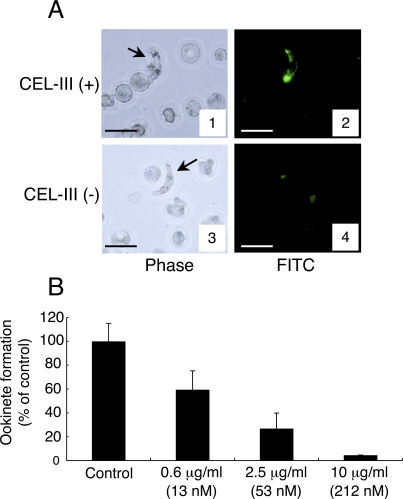
Binding of CEL-III to Ookinetes Inhibits Parasite Development In Vitro(A) Binding of CEL-III to ookinetes. CEL-III was added to cultured ookinetes purified from P. berghei–infected mouse blood. Bound CEL-III was detected with FITC-labeled anti-mouse IgG following mouse anti-CEL-III antibody by fluorescence microscopy (panels 1 and 2) (CEL-III (+)). As a negative control, ookinetes were incubated with FITC-labeled anti-mouse IgG following mouse anti-CEL-III antibody without CEL-III (panels 3 and 4) (CEL-III (−)). Panels 1 and 3, phase contrast; panels 2 and 4, FITC. Arrows indicate cultured ookinetes. Scale bars are 10 μm.(B) Effect of CEL-III on ookinete development in vitro. P. berghei–infected mouse blood was cultured for ookinetes for 24 h at 19 °C. CEL-III was added at initiation of the culture at various concentrations. Data are expressed as number of ookinetes relative to medium alone (100%). Results are the mean of two independent experiments, and bars represent standard errors of the mean.